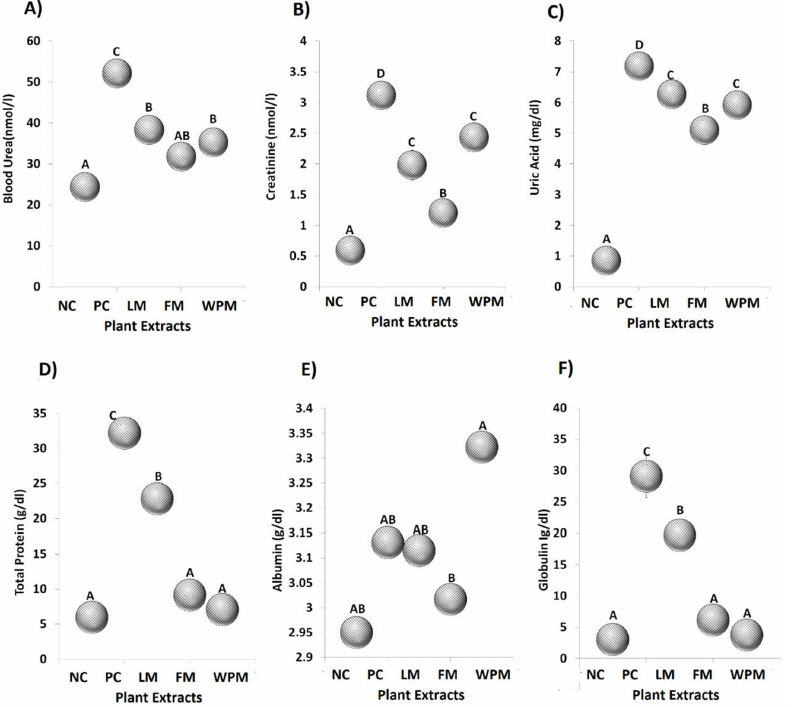
Figure 5. Effect of leaf, flower, and whole plant extract in contrast to negative and positive control (NC and PC) on renal function biomarkers; ( A ) blood urea, ( B ) creatinine, ( C ) uric acid, ( D ) total protein, ( E ) albumin, and ( F ) globulin. The different alphabet at chart bars showing significant difference.